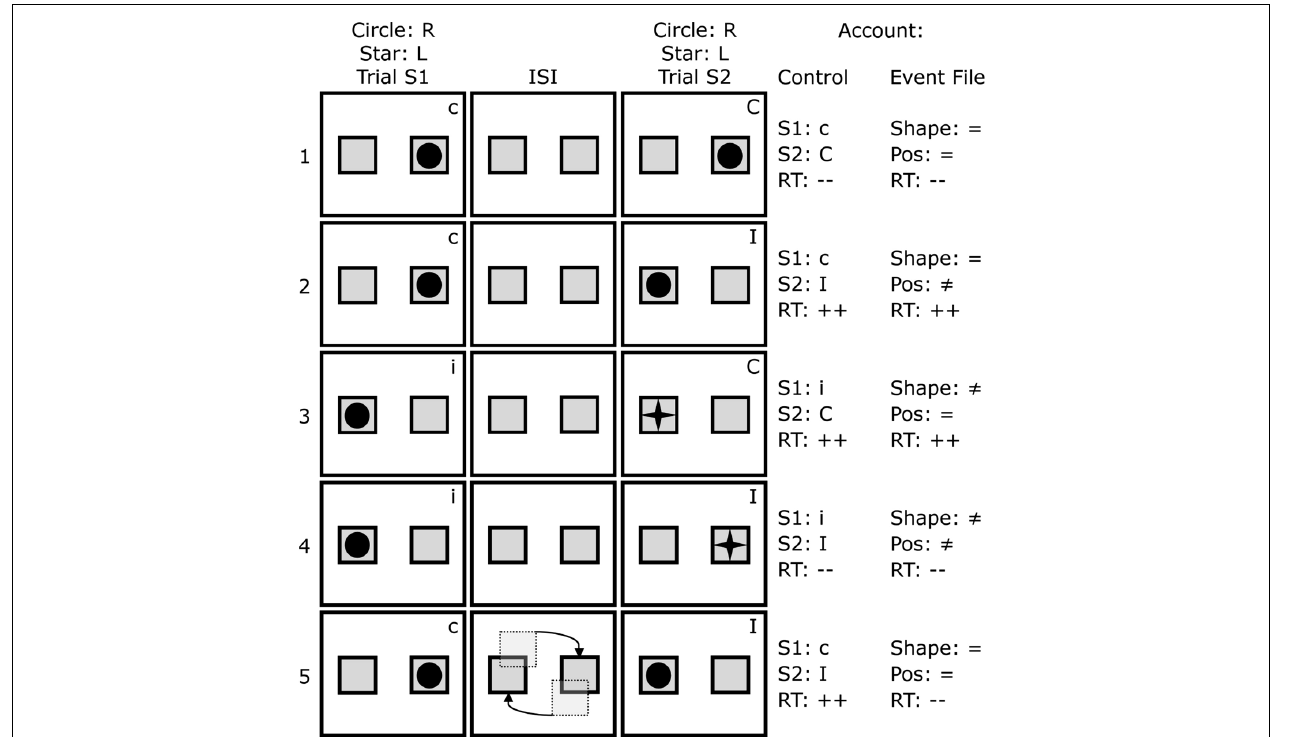
FIGURE 1 | Sequence of events in five trial pairs and coding in terms of conflict (Control account) and features (Event File account). Given that the participant responds right (R) to circles and left (L) to stars, the initially compatible (c) trial (S1) in pair 2 is followed by an incompatible (I) trial (S2), which usually results in increased reaction times (RT: ++ ). Increased reaction times are also predictable in